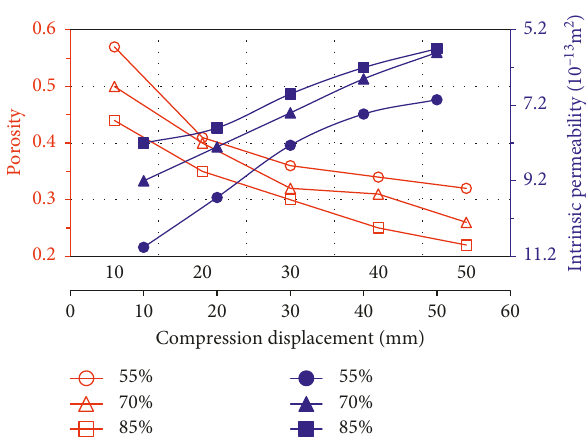
Figure 8: Test data of permeability and porosity under different water contents.